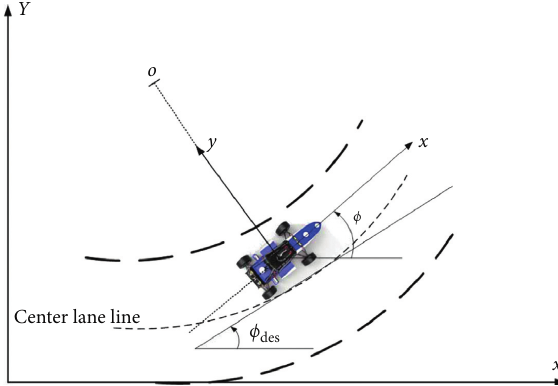
Figure 2: Lateral dynamics model of driverless